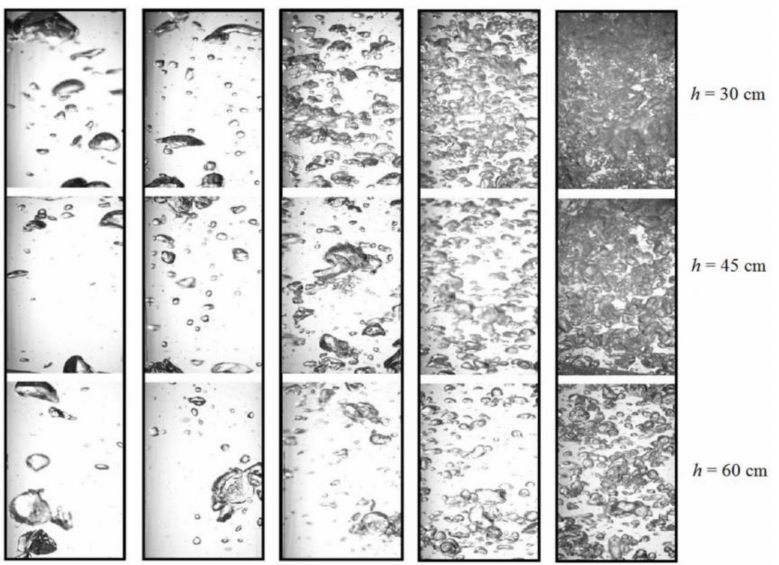
Figure 5. Instantaneous images illustrating the bubble size distribution along the column height at f = 10 Hz and (from left to right) A = 1.5 mm, 2.5 mm, 4.5 mm, 6.5 mm and 9.5 mm. ( H 0 = 85 cm, U SG = 5.0 mm/s, P 0 = 1